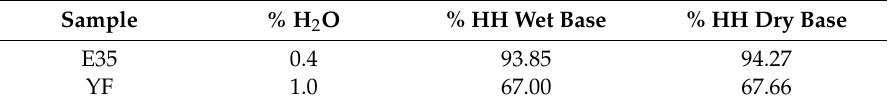
Table 1. Results of the thermal analysis of raw materials.